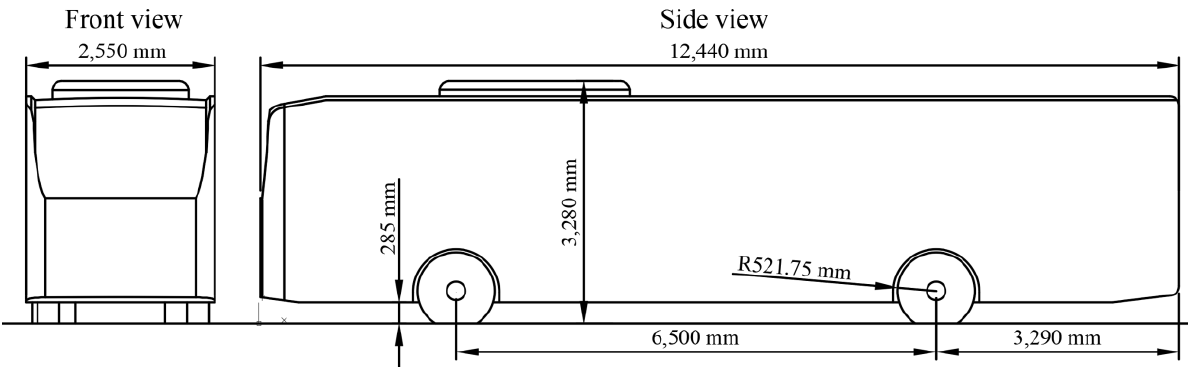
Figure 1. Schematic of the bus.